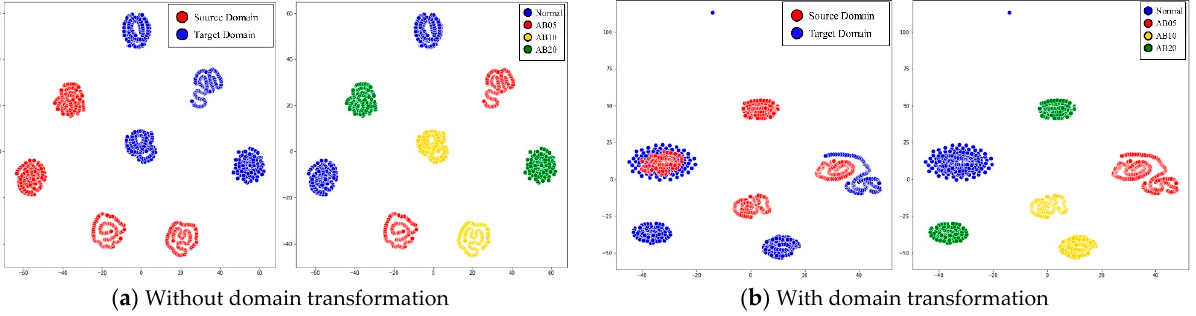
Figure 13. The t-SNE visualization of feature at latest hidden layer for each domain data such as source and target and each class in real machine.